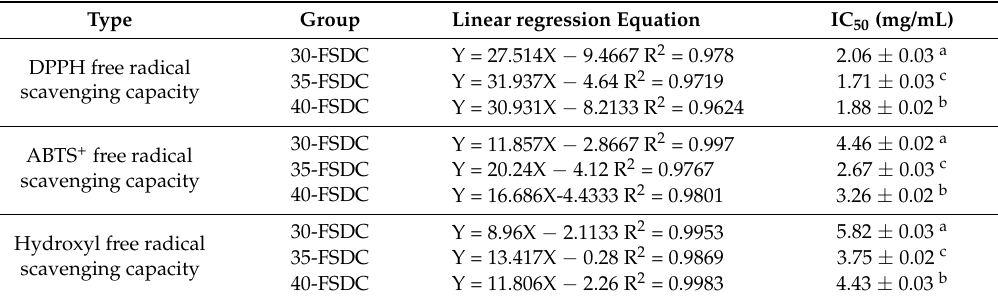
Figure 4. DPPH (2,2-Diphenyl-1-picrylhydrazyl) ( A ), ABTS + (2,2'-azino-bis(3-ethylbenzthiazoline) 6-sulphonic acid) ( B ), and hydroxyl ( C ) free radical scavenging capacity of Shuidouchi fermented at different fermentation temperatures. 30-FSDC: 30 °C fermented Shuidouchi; 35-FSDC: 35 °C fermented Shuidouchi; 40-FSDC: 40 °C fermented Shuidouchi. Table 6. DPPH (A), ABTS + (B), and hydroxyl (C) free radical scavenging capacity of Shuidouchi at different fermentation